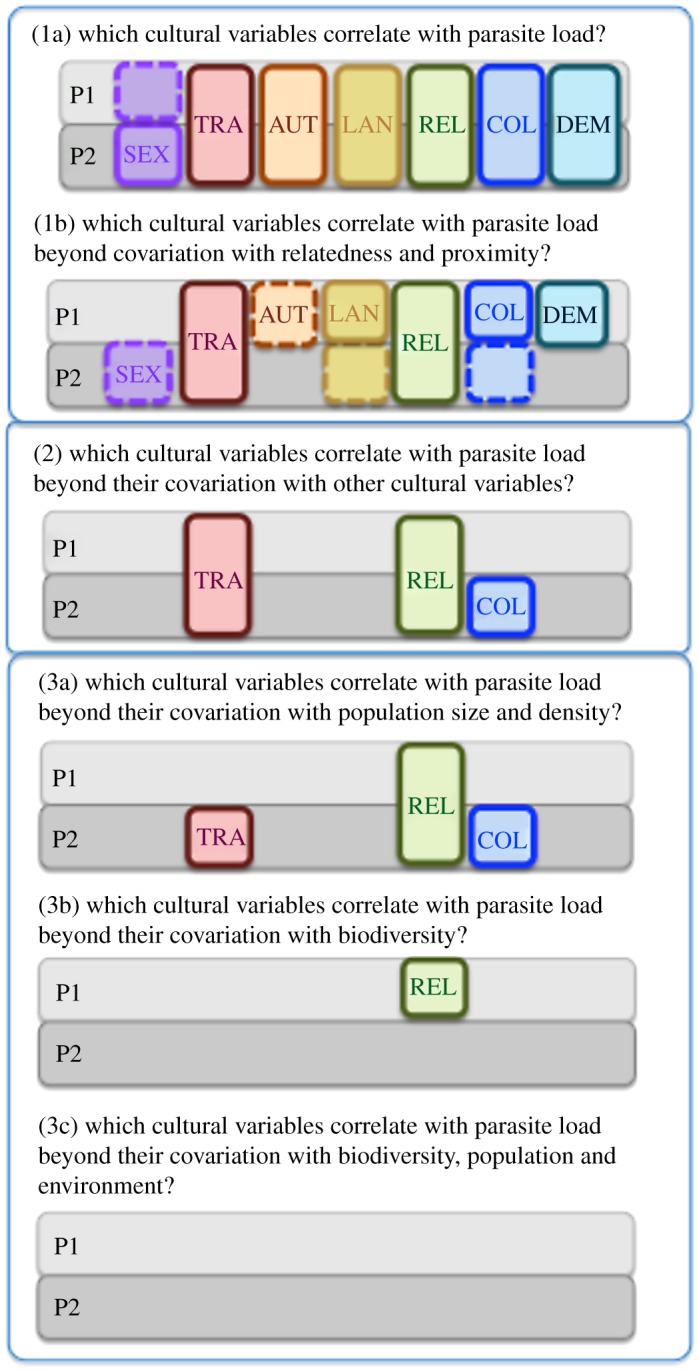
Schematic summary of the results of analyses. Boxes indicate a significant correlation between variables (table 1) and parasite load (p < 0.05). Dashed lines indicate results that would not be significant under a Bonferroni correction for multiple tests (p < 0.003). Details of statistical tests: (1, 2) table 3; (3) table 4; (3a) table 5; (3b) table 6; (3c) table 7.